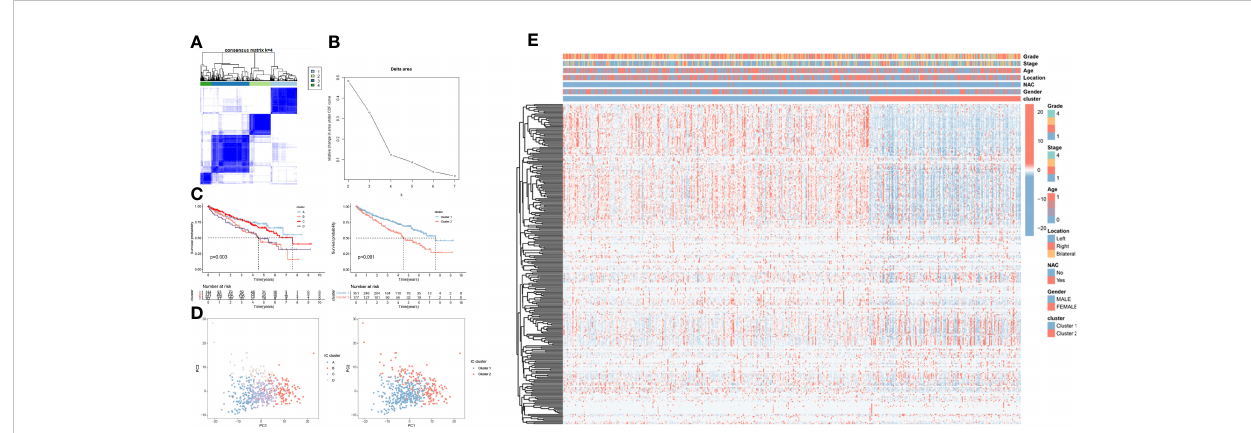
FIGURE 3 Molecular subtyping of ccRCC patients based on the CRGs in TCGA cohort. (A) The ccRCC patients were identi fi ed into 4 clusters according to the consensus clustering matrix (k=4). (B) Relative changes in the area under the CDF curve by group number (MaxK = 7). (C) Kaplan – Meier survival curves for the 2 clusters and 4 clusters. (D) Principal component analysis for the 2 clusters and 4 clusters. (E) The heatmap and the clinical parameters of the 2 clusters established based on the